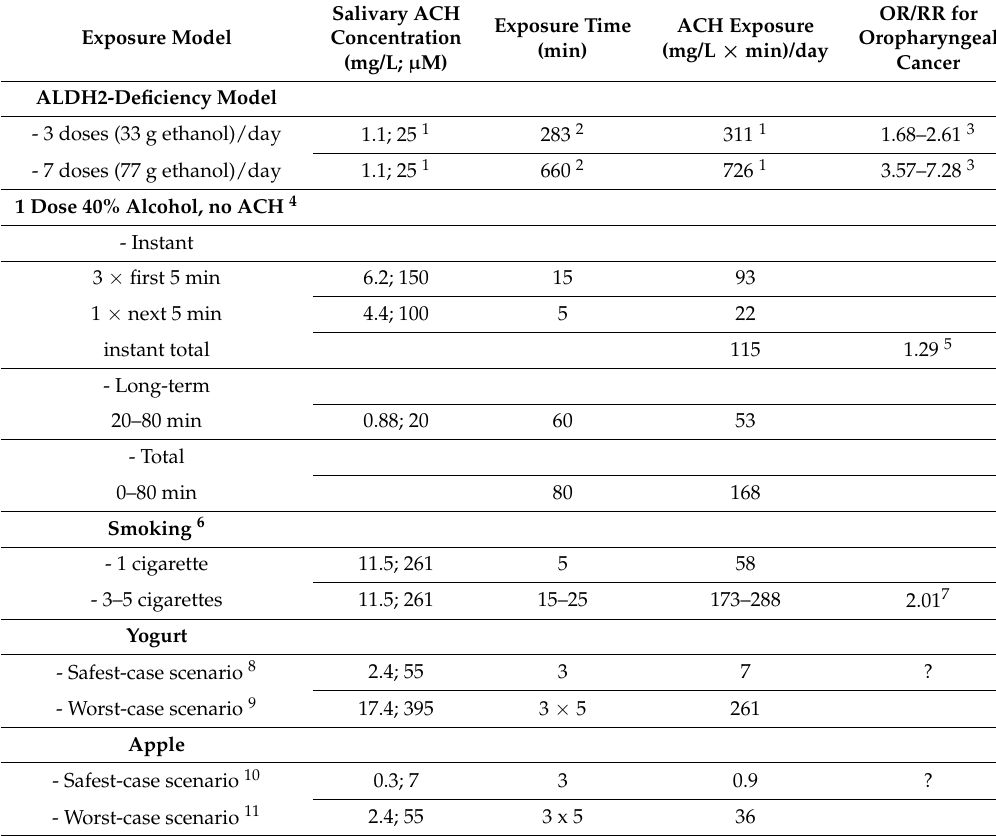
Table 2. Effect of ALDH2 deficiency, alcohol consumption, smoking, and certain foodstuffs on the quantitative exposure of oropharynx to acetaldehyde (ACH) via saliva in relation to the risk for oropharyngeal cancer. Calculations are based on selected examples as indicated in